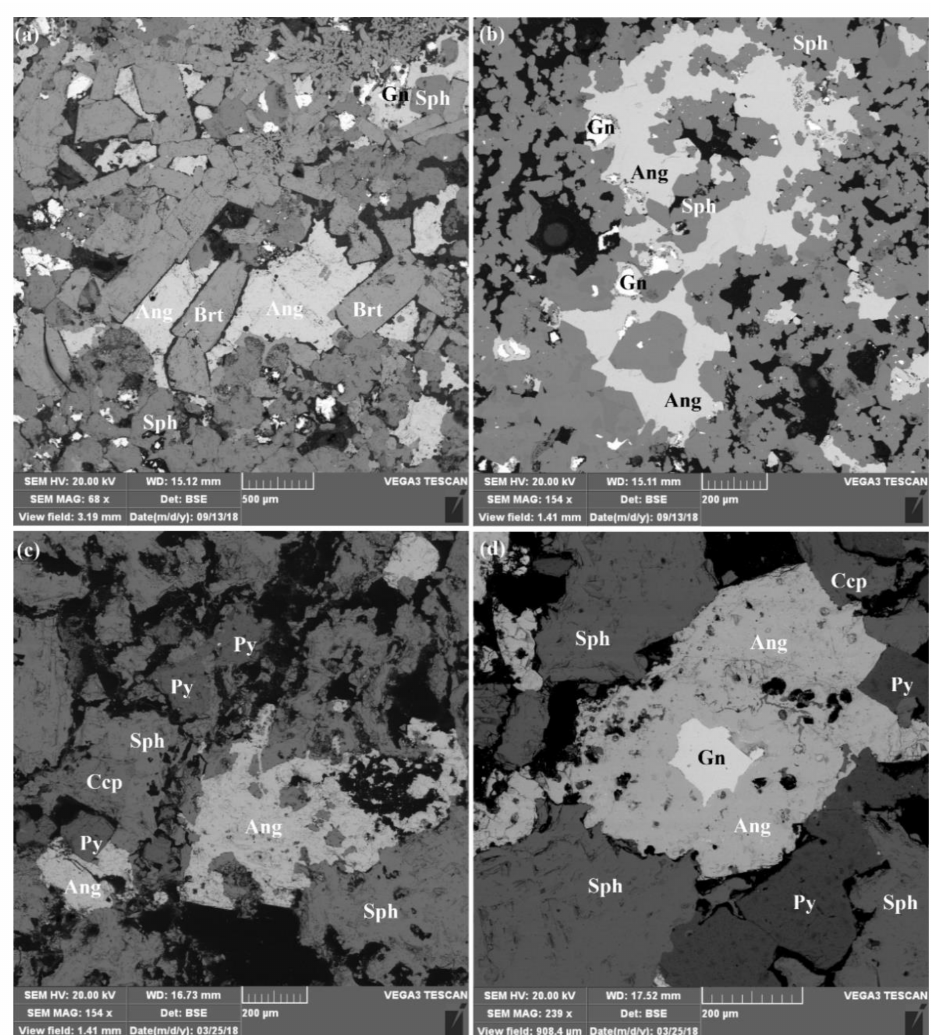
Figure 4. ( a ) SEM back-scattered electron (BSE) images of selected anglesite and sulfide minerals hosting Ag and Bi in seafloor hydrothermal sulfide deposits, Okinawa Trough. ( a ) Sample H3-T9-10-2: Intergrowth of large subhedral to euhedral barite, anglesite, sphalerite and galena forming porous structures. ( b ) Sample H4-TVG10-2-1: Anglesite replacing galena. Fluid channels with sphalerite infill indicate their later formation. ( c ) Sample H2-R1-2-a4: Intergrowth of sphalerite and pyrite forming large porous structures. Some pores filled with anglesite minerals indicate their later formation. ( d ) Sample H2-R1-2-b3: Intergrowth of sphalerite, pyrite and chalcopyrite forming porous